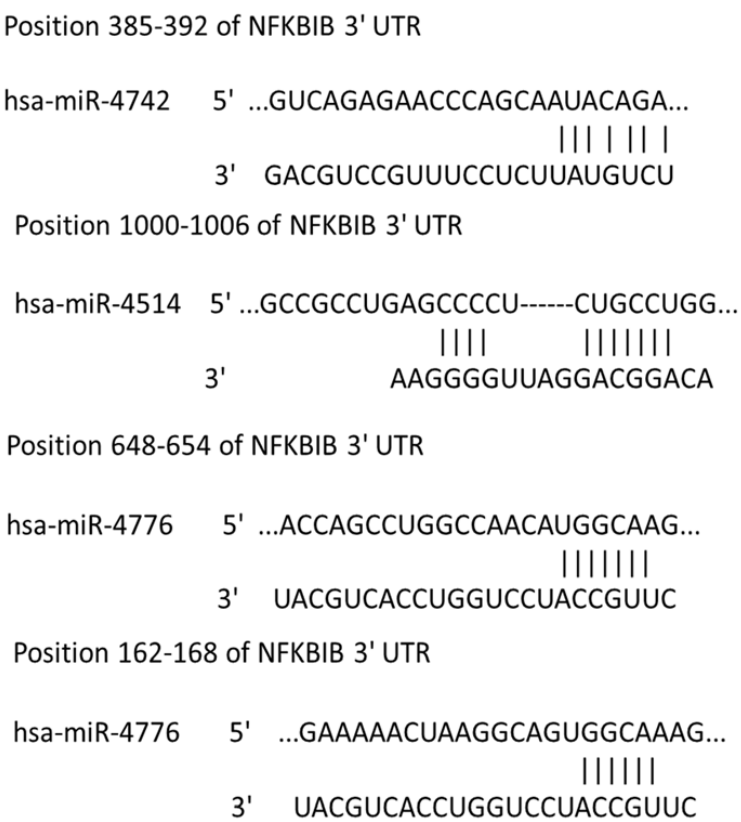
Figure 2. Target scan analysis of nuclear factor Kappa B inhibitor beta (NFKBIB) three prime untranslated region (3’ UTR). A search of the sequences for miRNAs miR-4514, 4742, and 4776 showed putative target binding sites in NFKBIB messenger RNA (mRNA).